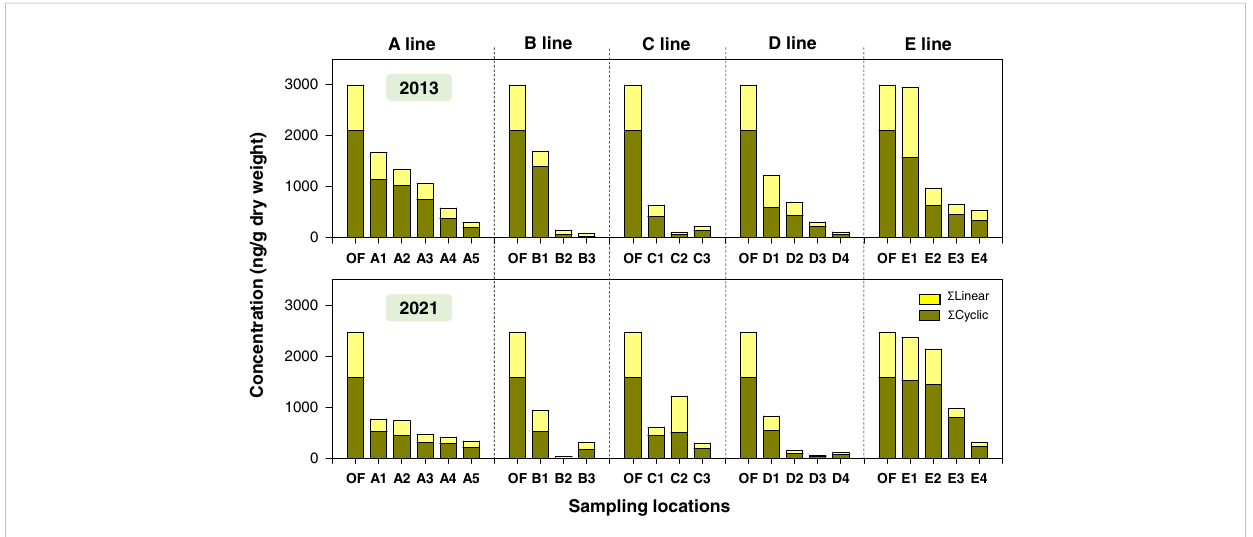
FIGURE 3 Concentrations of cyclic and linear siloxanes in sediment from the sampling locations of each transect line from the submarine outfall of a wastewater treatment plant in Masan Bay, Korea collected in 2013 and